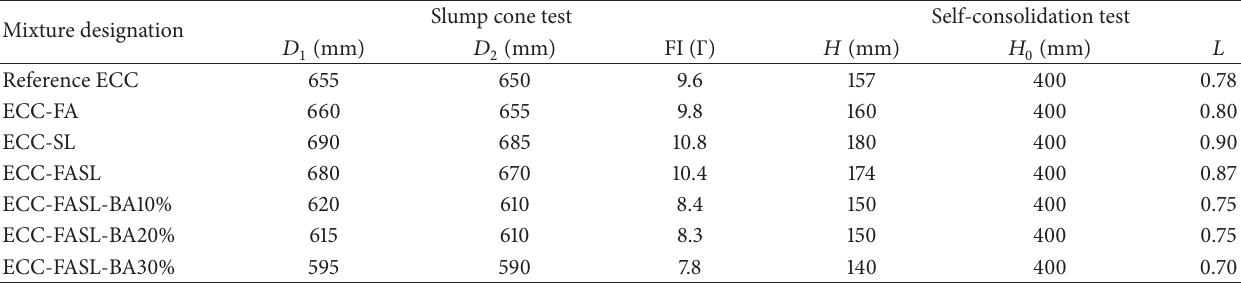
Table 4: Test results of slump cone and self-consolidation test of all ECC